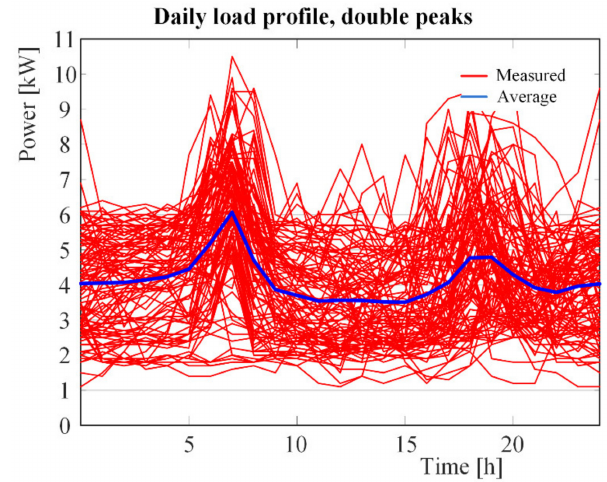
Figure 5. The double-peaks consumption